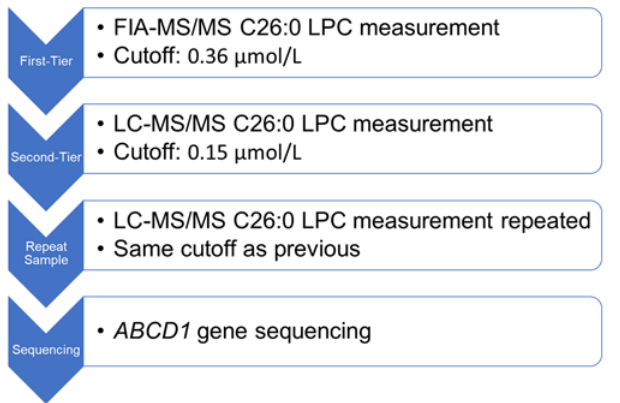
Figure 1. The Pennsylvania X-ALD newborn screening algorithm utilizes a tiered approach. C26:0- LPC is measured first with flow injection analysis tandem mass spectrometry (FIA-MS/MS), then with liquid chromatography tandem mass spectrometry (LC-MS/MS). Repeat dried blood spot samples were requested for newborns with concerning second-tier screens. Sequencing of the ABCD1 gene was performed for repeat specimens with C26:0-LPC exceeding the cutoff value.